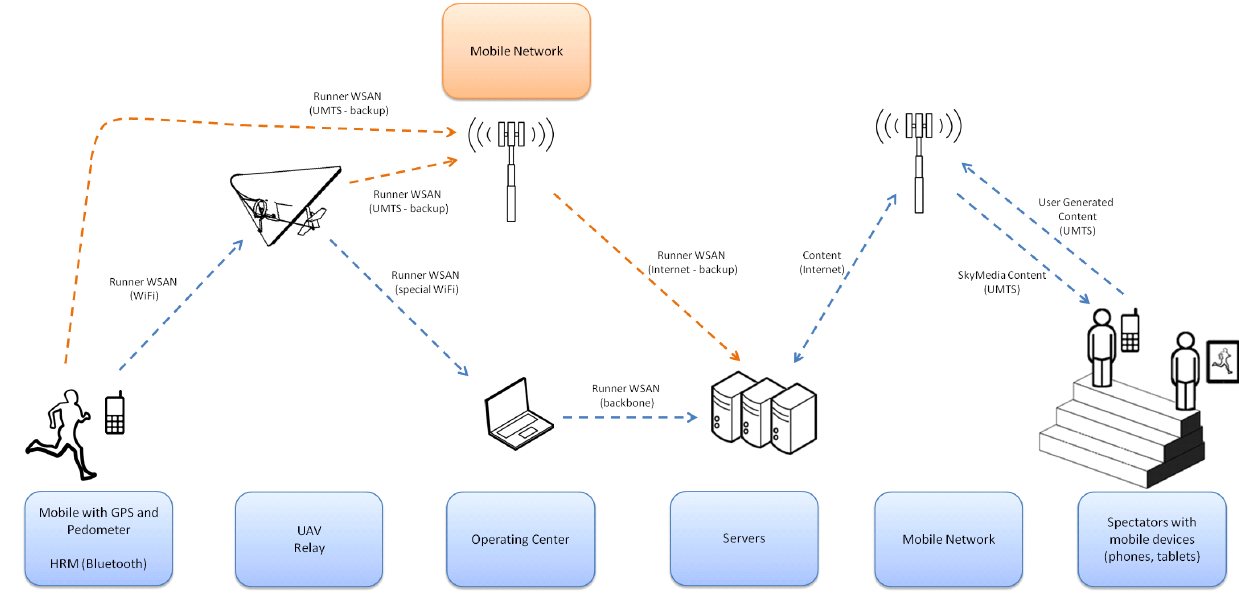
Schematic description of a UAV employed as a relay for the terrestrial sensor